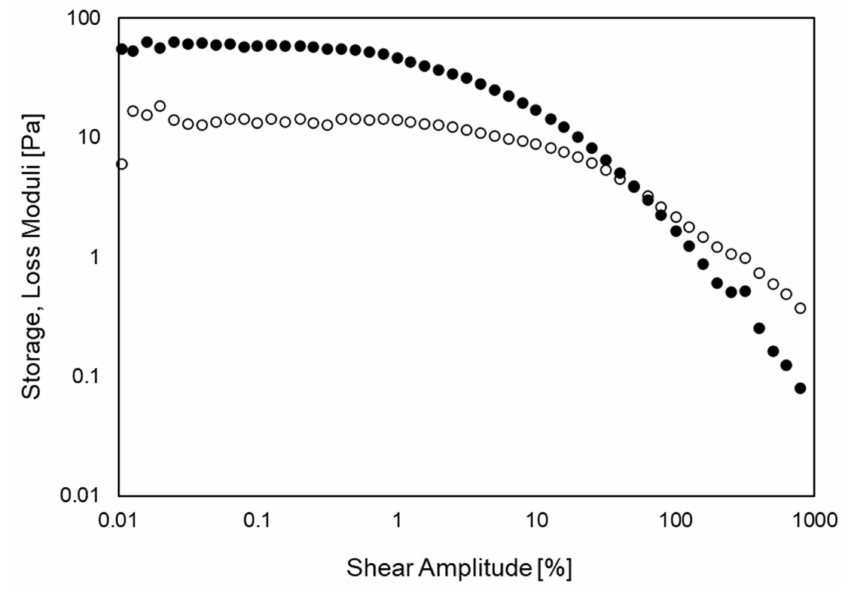
Figure 2. Amplitude sweep of MCF-7 cells treated with paclitaxel. Storage and loss moduli are indicated by closed and open symbols, respectively. Angular frequency: 1 rad/s; Gap width: 13 µ